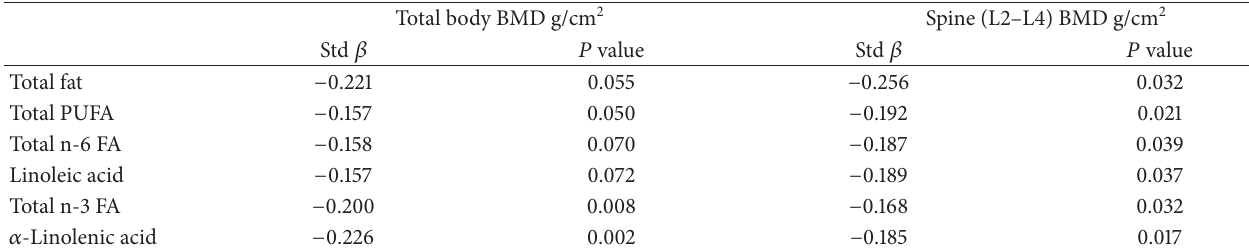
Table 2: Significant one-year nutrient associations with bone mineral density using multiple regression analysis in 266 postmenopausal